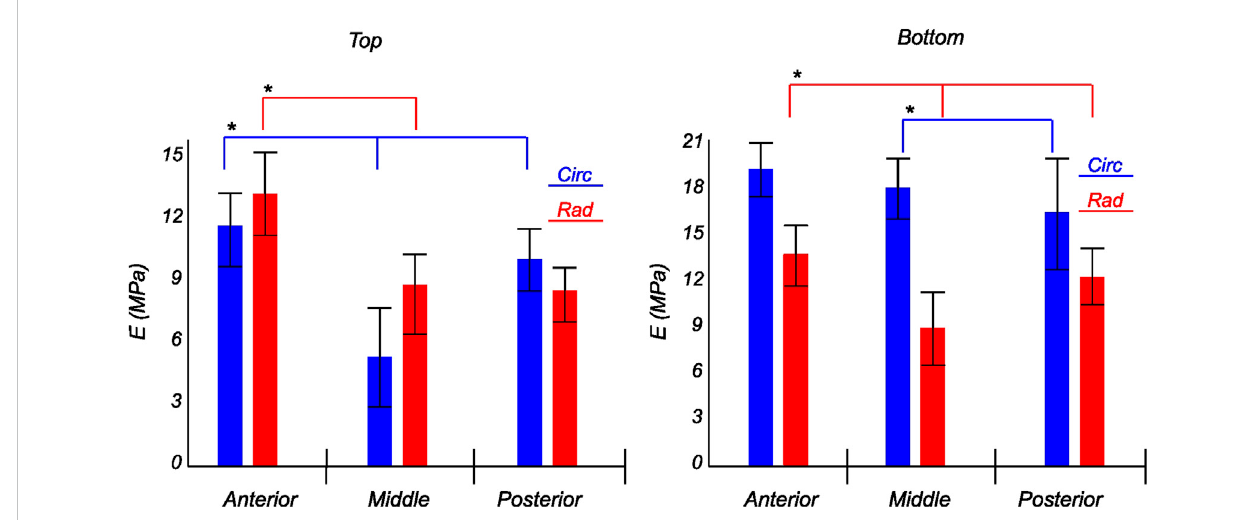
FIGURE 10 Computedelasticmodulusofahumanlateralmeniscusinthe fi nalloadingregime:toplayer(left),andbottomlayer(right).Theanisotropicnatureof the material is shown with the circumferential stiffness represented in blue and the radial stiffness represented in red. Within each layer, the anterior, middle, and posterior regions are presented to see the regional variations. * indicates statistical signi fi cance from a one-way ANOVA test with p -value < 0.05.